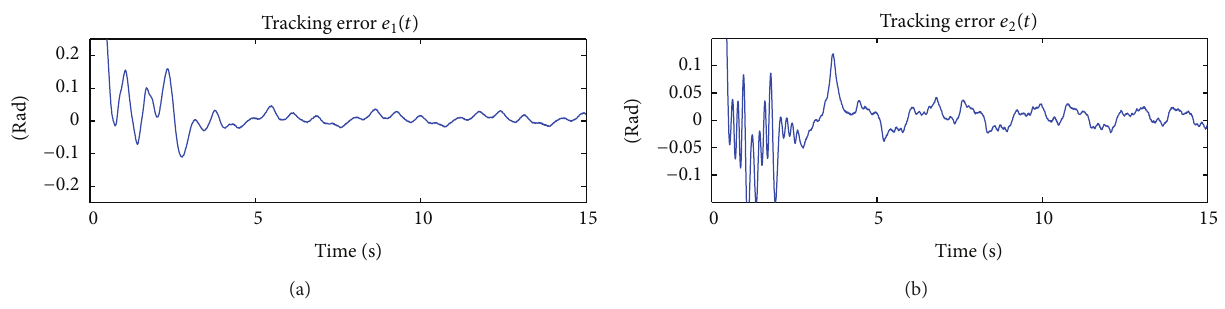
Figure 6: Tracking errors 𝑒 1 (𝑡) and 𝑒 2 (𝑡) by using the ANN + PD + Δ sign ( r ) scheme which considers adaptation.